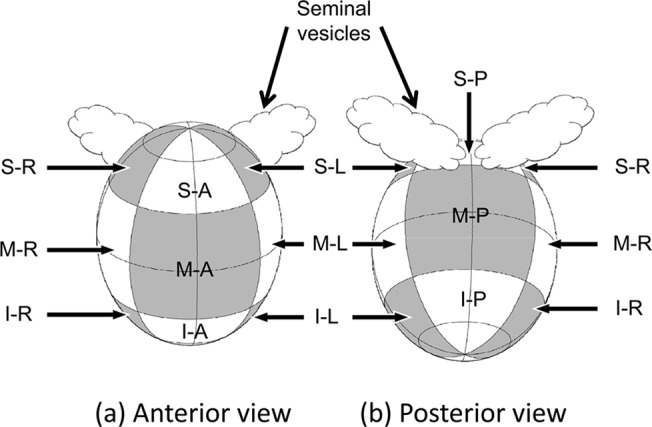
Division of the prostate gland into 12 segments.Superior-anterior (S-A), superior-posterior (S-P), superior-right (S-R), superior-left (S-L), middle-anterior (M-A), middle-posterior (M-P), middle-right (M-R), middle-left (M-L), inferior-anterior (I-A), inferior-posterior (I-P), inferior-right (I-R), and inferior-left (I-L). The prostate was divided into three approximately equal segments in the slice dimension (the first 1/3 of the prostate volume was termed the superior segment, and the last 1/3 was termed the inferior segment) and into four equal segments in each slice (anterior, posterior, right, and left segments).